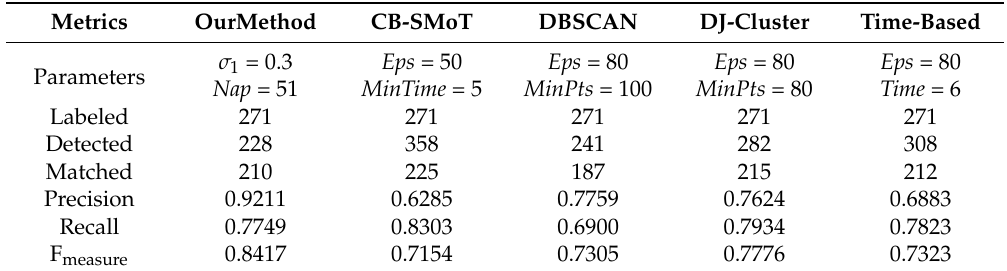
Table 2. Experimental results with the Geolife